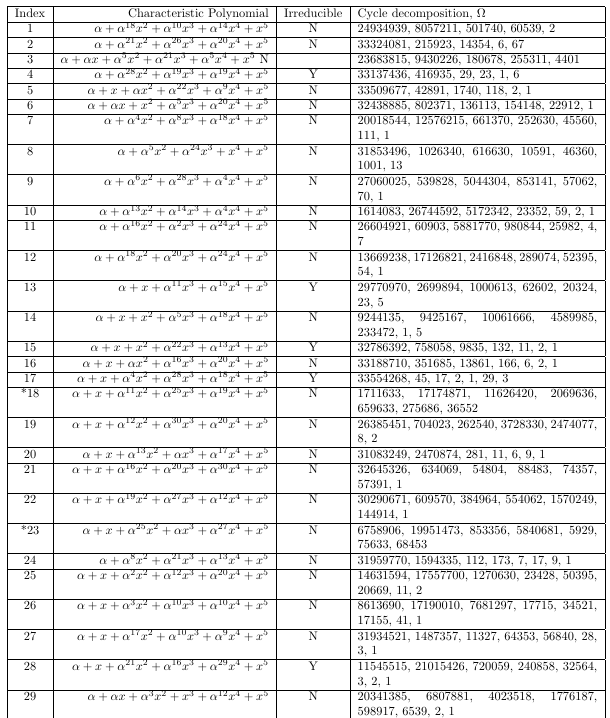
Table 3. Complete cycle decompositions of the WG- NLFSR for n = 5 over F 2 5